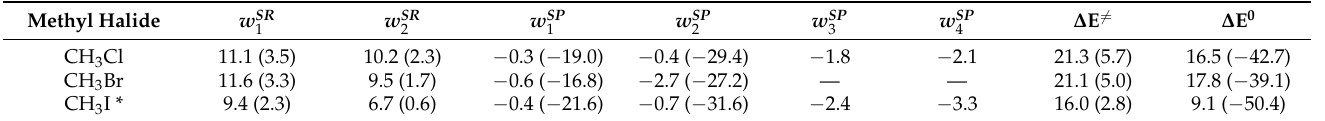
Table 1. RF works, activation ( ∆ E (cid:54) = ), and reaction ( ∆ E 0 ) energies in kcal/mol, calculated at the u ω B97-XD/6–311++G(d,p) level and obtained from the IRC